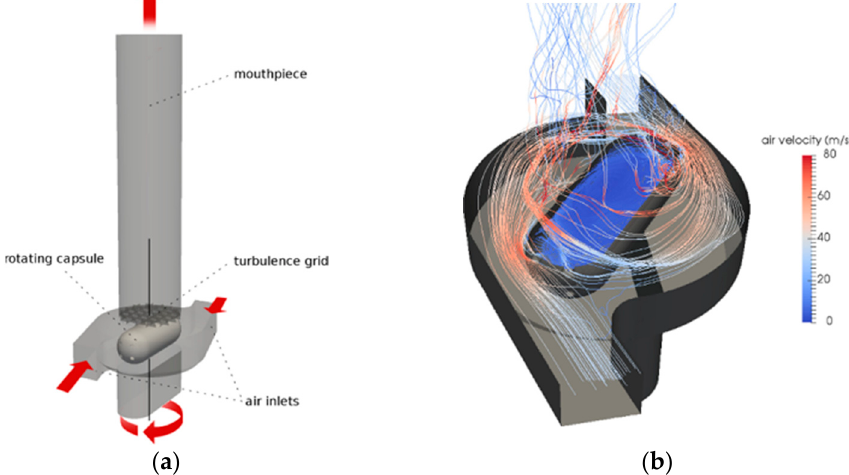
Figure 5. ( a ) Schematic of an Aerolizer ® inhaler with a pierced capsule and ( b ) streamlines in the capsule chamber. Reproduced/Adapted with permission from [10], Elsevier,